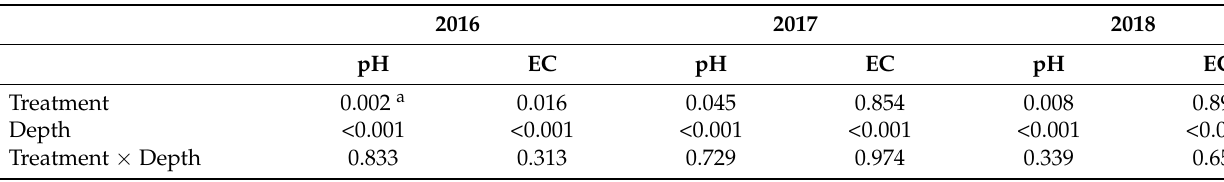
Table 4. Results of ANOVA for soil acidity (pH) and electrical conductivity (EC, µ S cm –1 ) with annual applications of combi- nation of nitrogen fertilizer and nitrification inhibitors (2-chloro-6-(trichloromethyl)-pyridine (Nitrapyrin), dicycandiamide (DCD)) in soils collected in fall at different depths (0–15 cm, 15–30 cm and 30–60 cm) in 2016, 2017 and 2018 in a long-term blueberry experiment (N = 108).